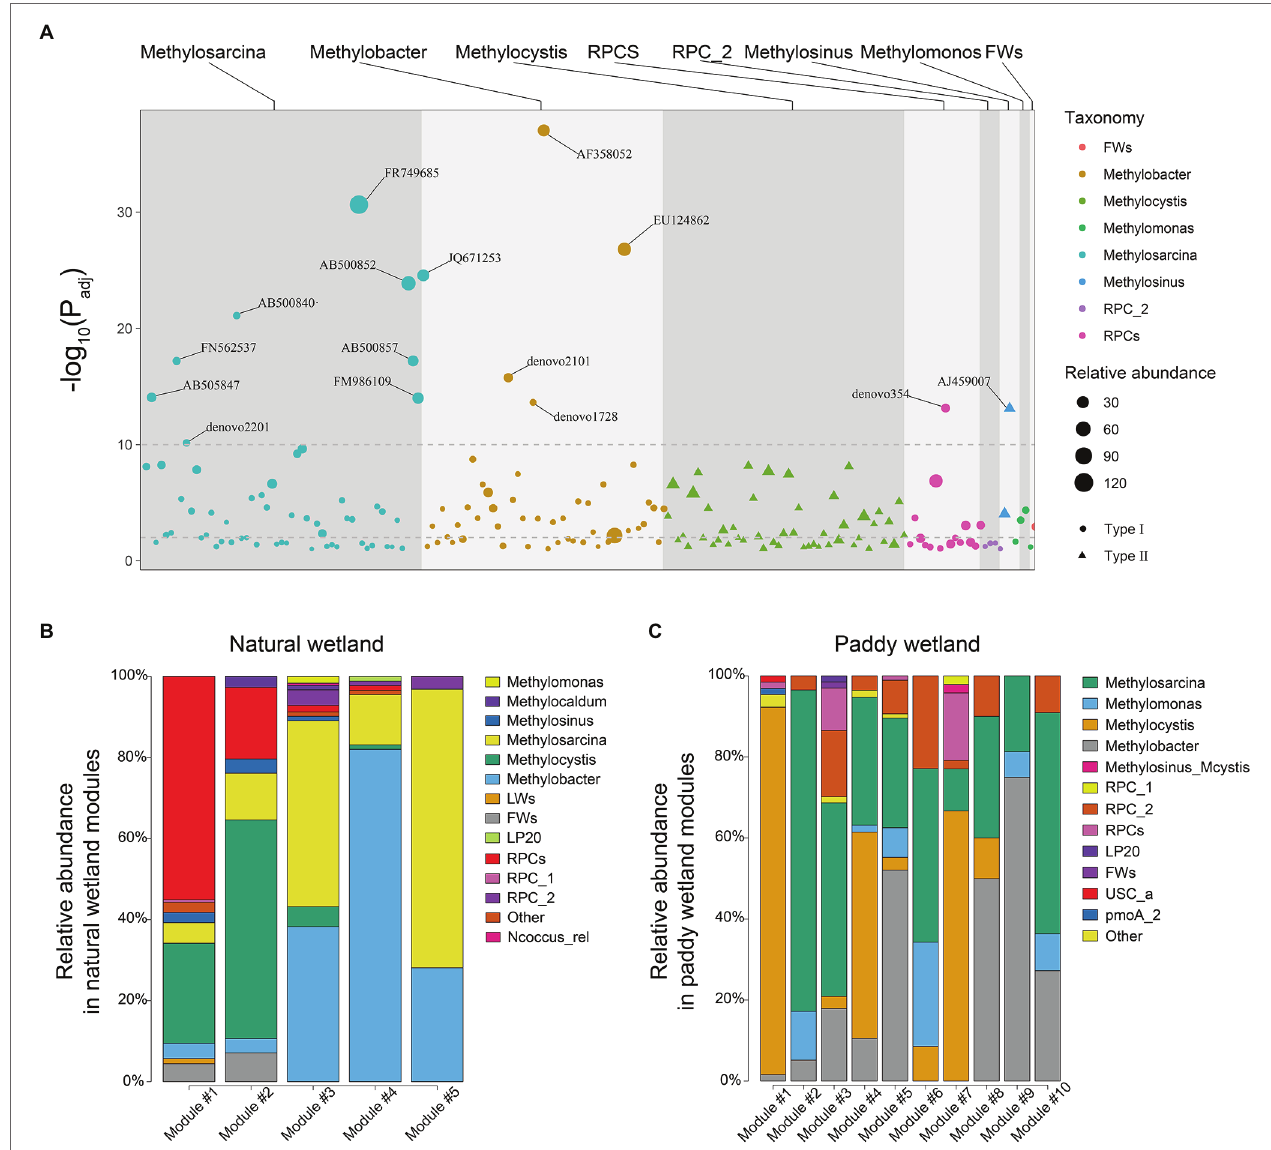
FIGURE 5 | (A) Manhattan plots showing differential operational taxonomic units (OTUs) in networks of paddy and natural wetlands. OTUs that belonged to Type I were depicted as circles shape where Type II OTUs as triangle shape. The dashed line corresponded to the adjusted value of p threshold of significance ( α = 0.01/0.001). The color of each dot represented the different taxonomic affiliation of the OTUs, and the size corresponded to their abundance in the respective samples. Gray backgrounds were used to denote the different taxonomic groups. (B,C) Relative abundance of the dominant genus in the respective main ecological modules of natural and paddy wetland networks,